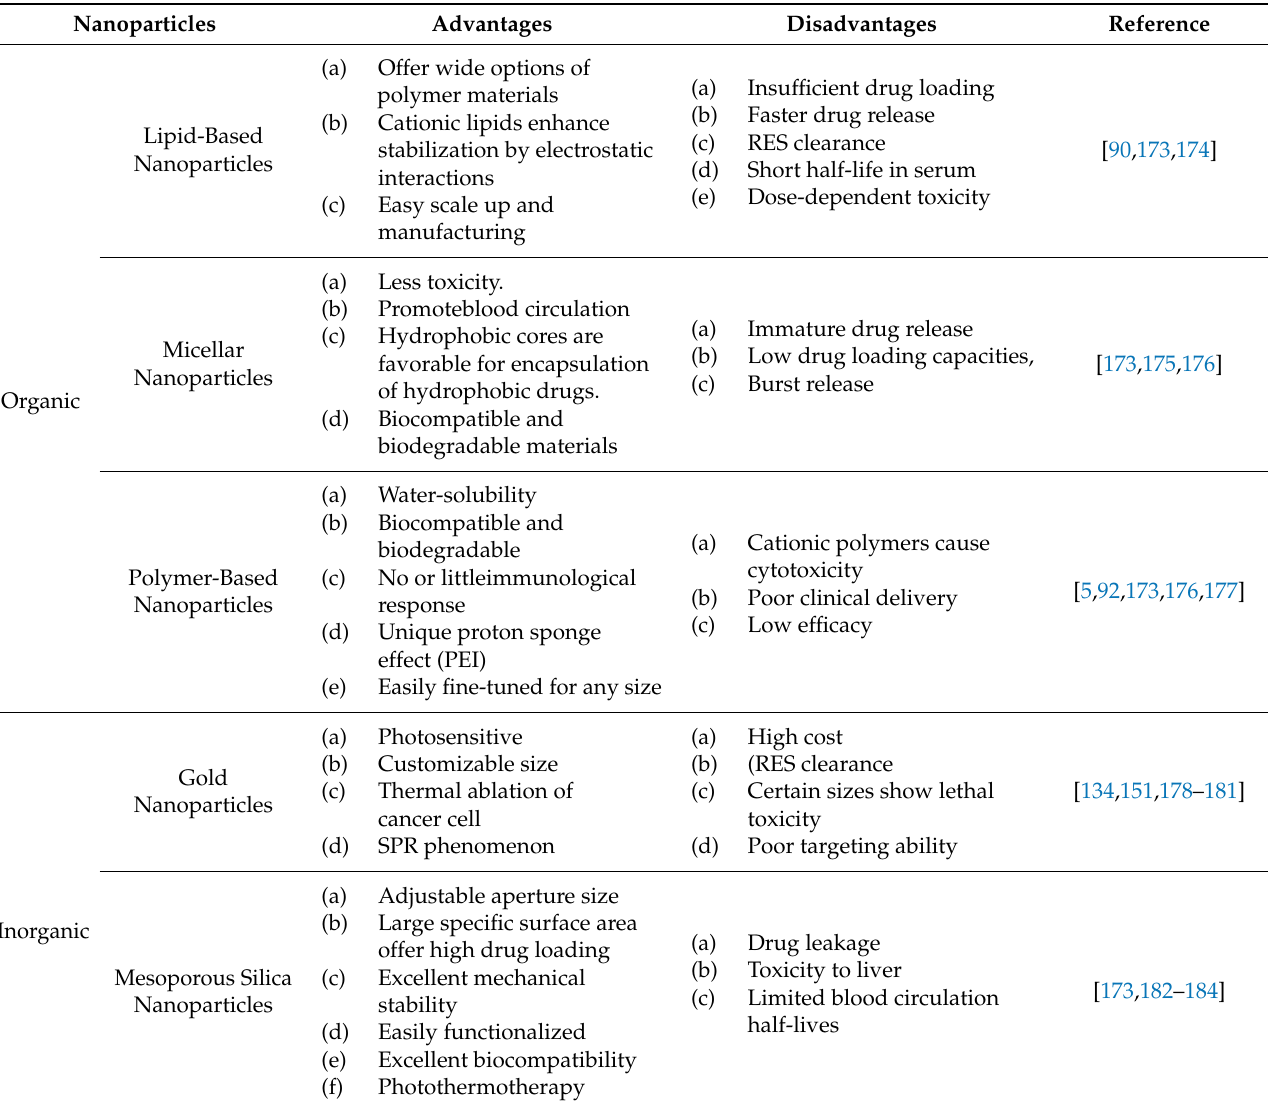
Table 3. A summary of the advantages and disadvantages of different nanoparticles. Nanoparticles Advantages Disadvantages